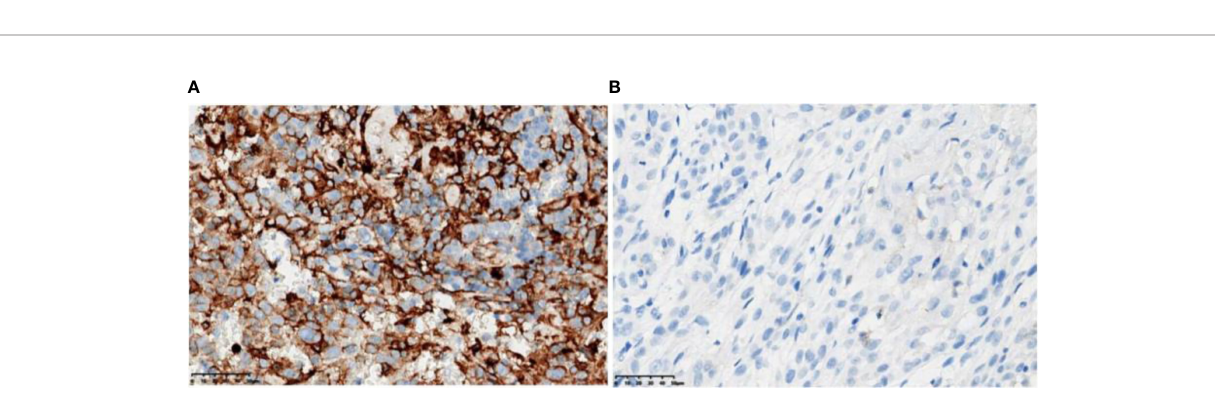
FIGURE 3 | PD-L1 immunohistochemistry test (antibody model: SP263). (A) Patient A has a positive PD-L1 immunohistochemistry with 50% to 60% PD-L1-positive tumor cells (TC) and 15% PD-L1-positive tumor-associated immune cells (IC). (B) Patient B was negative for PD-L1 immunohistochemistry with <1% TC and 1% IC.